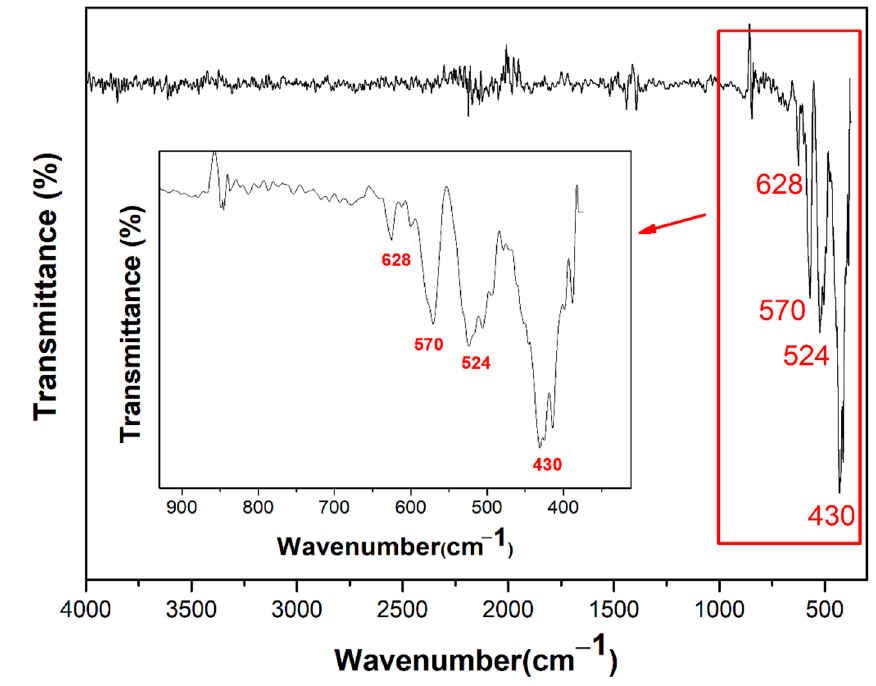
Figure 2. FTIR spectrum of ZnBi 2 O 4 .